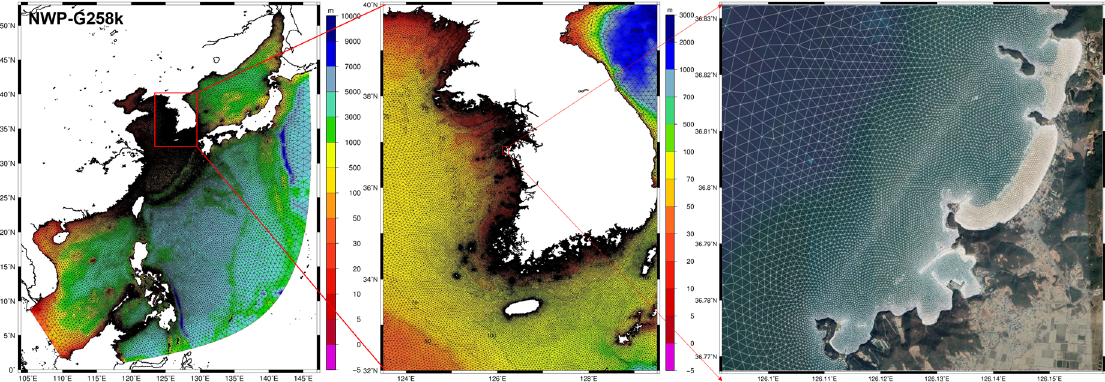
Figure 5. Unstructured grid system, NWP-G258k, with locally refined grid for field experiment